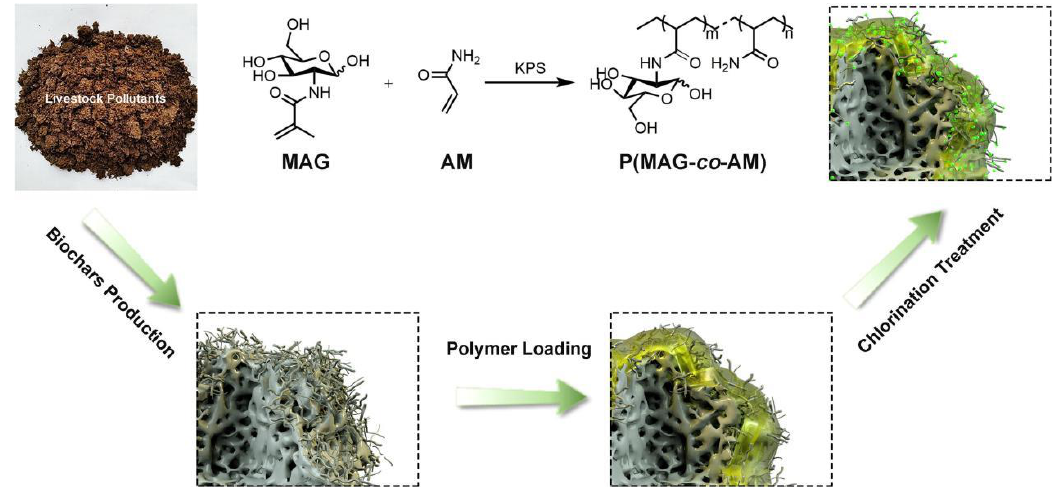
Figure 5. Schematic diagram of the synthesis of BCPMA − Cl for specific killing of Escherichia coli . Figure reproduced from ref. [31] with permission.